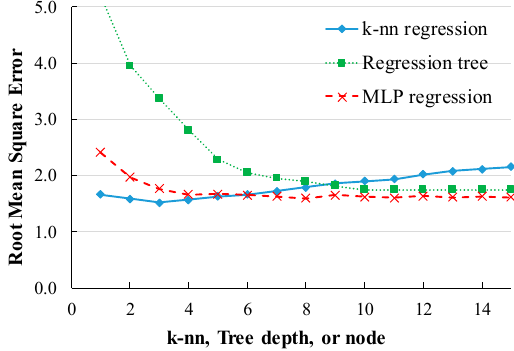
Figure 5. RMSE comparison of the three algorithms.